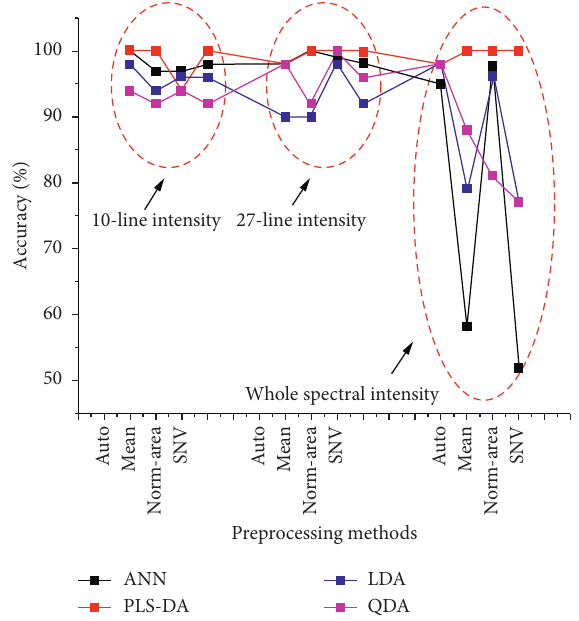
Figure 8: Accuracy of the ANN, PLS-DA, LDA, and QDA model by using different preprocessing methods for different types of input